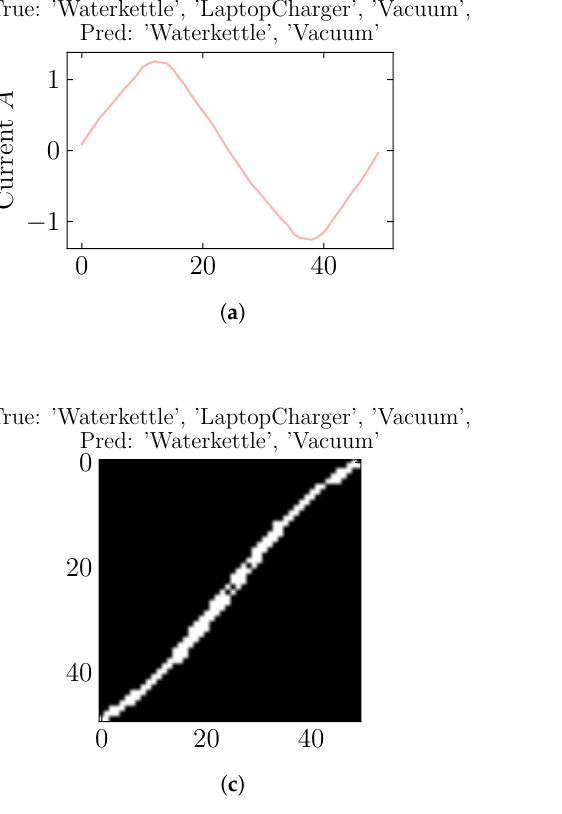
Figure 9. Prediction comparison for different feature representations with the proposed CNN multilabel classifier. ( a ) Action current. ( b ) Decomposed current. ( c ) V-I image. ( d ) Distance